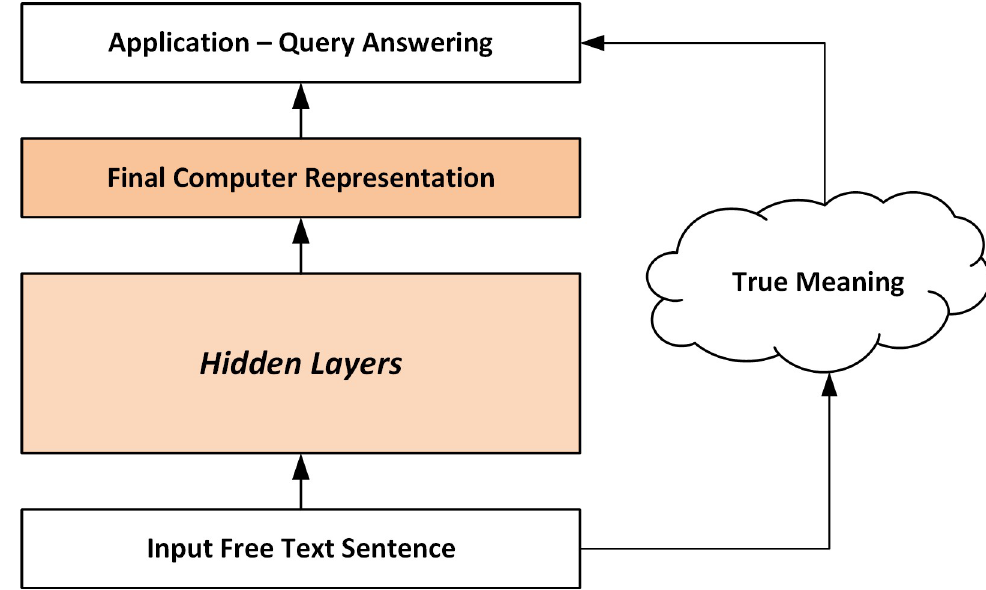
Fig 1. Overall basic mapping problem. The NLU problem maps the characters of a sentence to a conceptual representation of meaning. Defining the “internal semantic layers” is a key representational